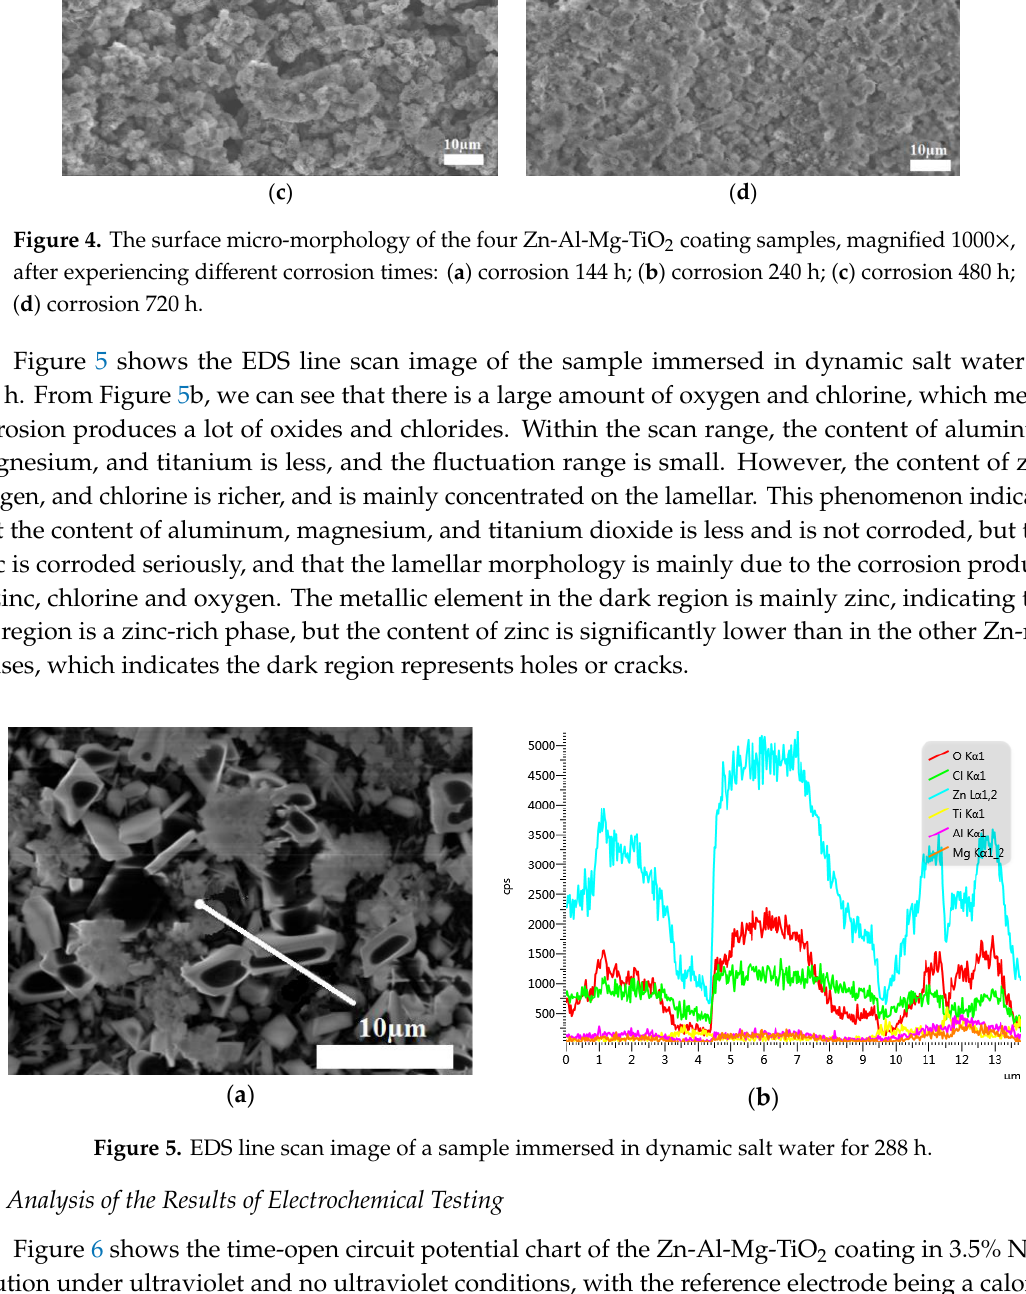
Figure 5. EDS line scan image of a sample immersed in dynamic salt water for 288 h.